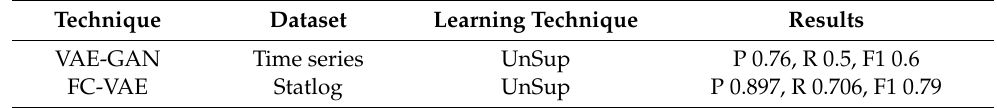
Table 3. Evaluation of proposed model with different